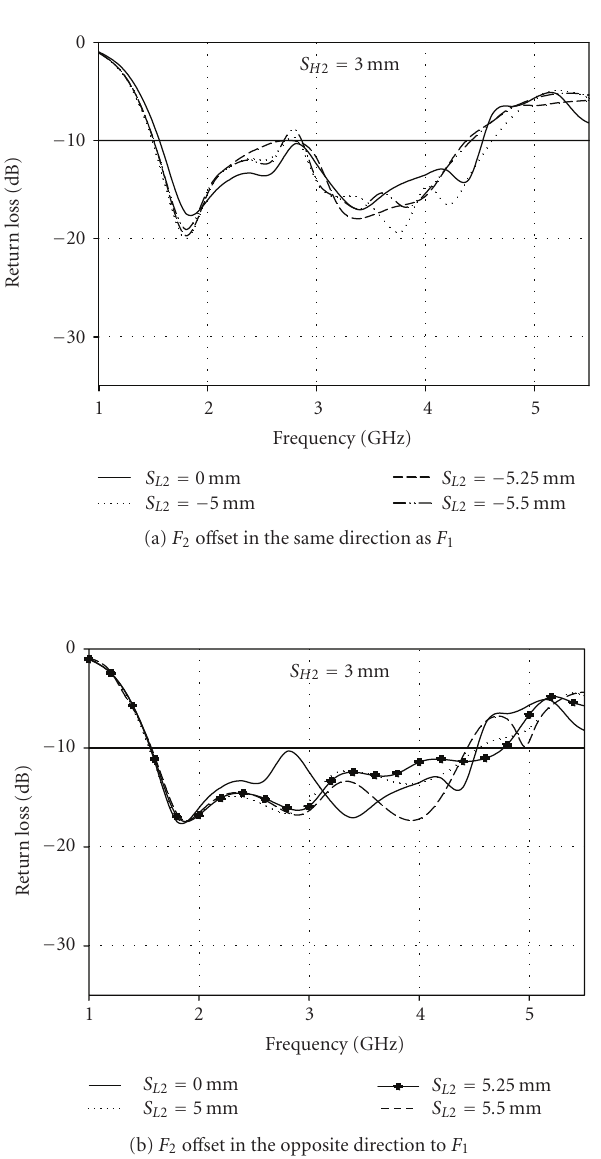
Figure 3: E ff ect of position of patch F 2 on return loss characteristics [ L = 67, W G = 67, L G = 29, L M = 15, W M = 3, W R = 7 . 5, L R = 19, S . 3, S . 5, S h = 1 . 6 (units in mm), R R = 11, H 1 = 0 L 1 = 6 H 2 = 3, . ε r = 4